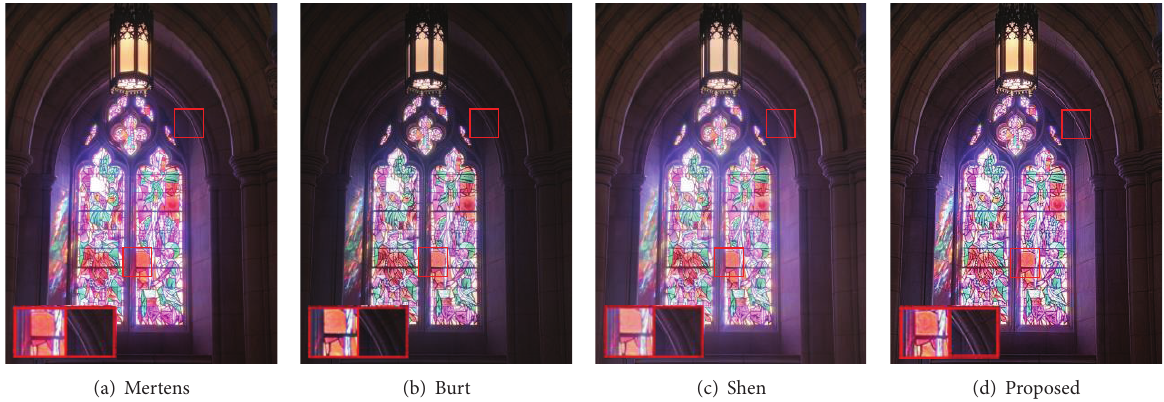
Figure 3: Comparison results to other recent exposure fusion techniques. (a) Mertens et al. [4], (b) Burt and Adelson [13], (c) Shen et al. [7], and (d) results of our new exposure fusion method. Note that our method yields enhanced texture and edge features. Input image sequence is courtesy of Tom Mertens.